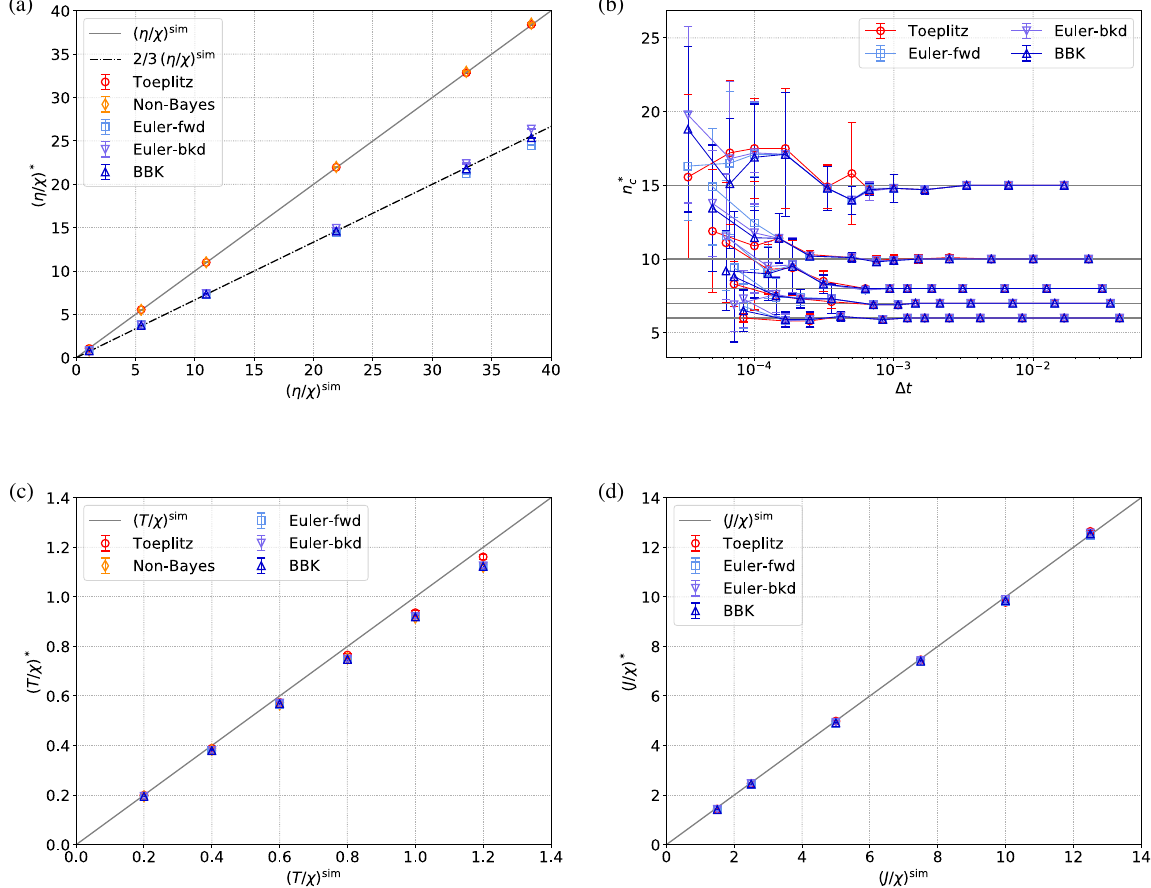
FIG. 5. Inference results for the inertial spin model. (a) Inferred values for the effective damping coefficient η = χ . We notice the emergence of a 2 = 3 rescaling factor for naïve methods derived from first-order Taylor-Itô expansions. (b) Inferred topological interaction range from numerical minimization of the reduced minus-log-likelihood, which is properly defined only in the Toeplitz scheme and in the three lower-order variants of the Euler scheme. (c) Inferred values for the parameter T= χ , as derived from Eq. (41). One notices a slight divergence from the slope-1 line, which is especially evident at large temperatures. This divergence is due to the spin-wave approximation (SWA), whose first correction impacts only the temperature parameter and can be explicitly evaluated, as explained in Appendix C. (d) Inferred values of the interaction strength ð J= χ Þ (cid:3) vs the parameter value used in simulations, ð J= χ Þ sim . All methods retrieve the correct results. We remark that only the parameters in the left panels, η = χ and T= χ , can be estimated by the non-Bayesian method. In all the simulations, we take flocks of N ¼ 1000 birds. Additional information about the choice of the model parameters and numerical methods can be found in Appendix D. Points in (a), (c), and (d) are obtained as in the case of the harmonic oscillator (see Fig. 1). For the O ð Δ t 1 = 2 Þ methods, we consider the different integration schemes defined in Appendix B